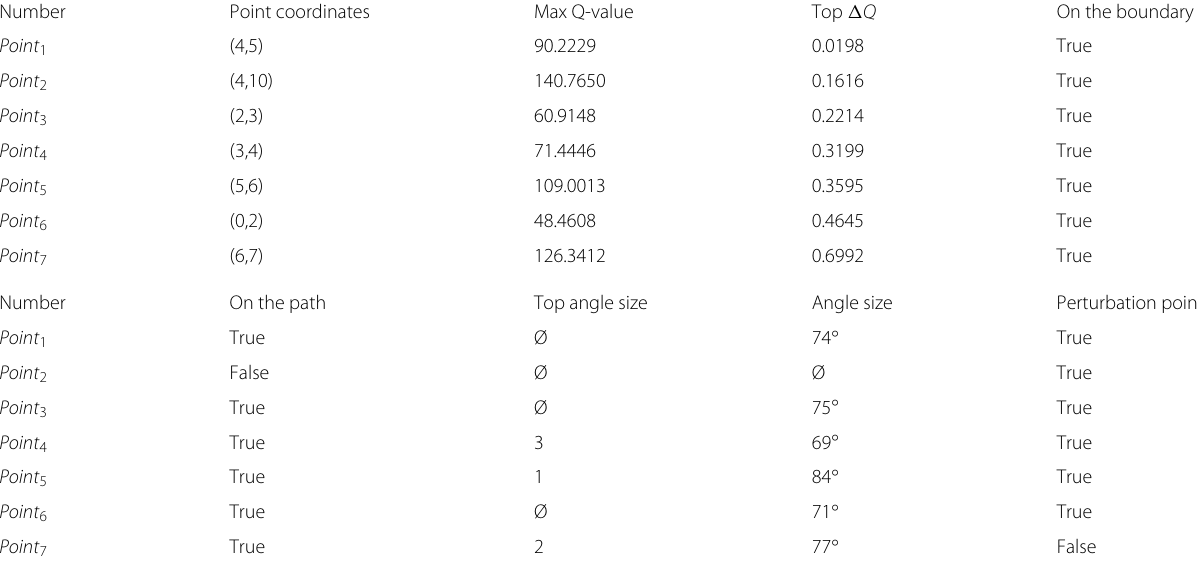
Table 2 Features for adversarial perturbations against single same original clean map, which can show how the different characteristics affect the interference of adversarial example